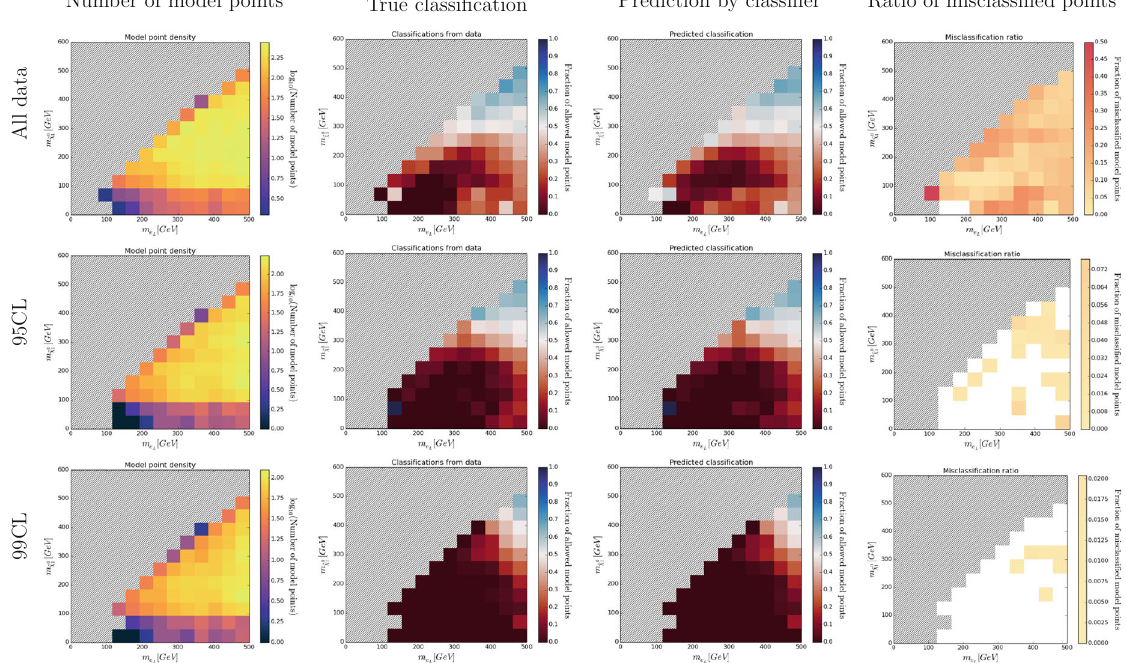
Fig. 14 Color histograms for a projection of the 19-dimensional pMSSM parameter space on the m ˜ (cid:5) in the second and third column indicates the fraction of allowed data points for the true classification and the out-of-bag